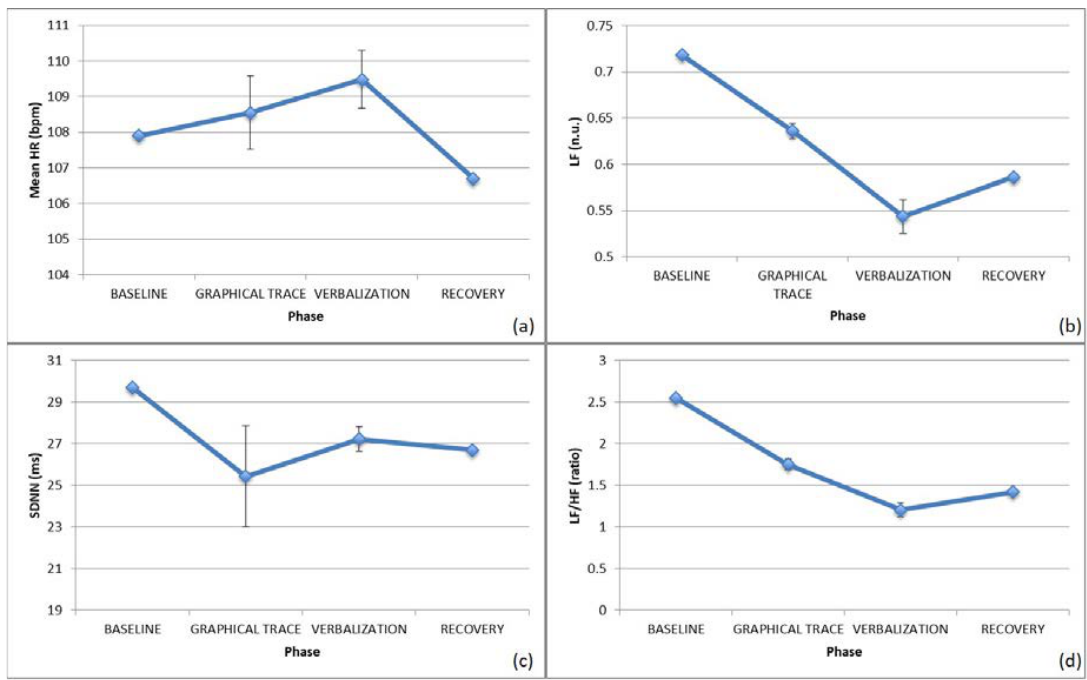
Figure 4. ECG features for B. during the various phases of the graphical trace: ( a ) HR, ( b ) LF, ( c ) SDNN, ( d ) LF/HF.